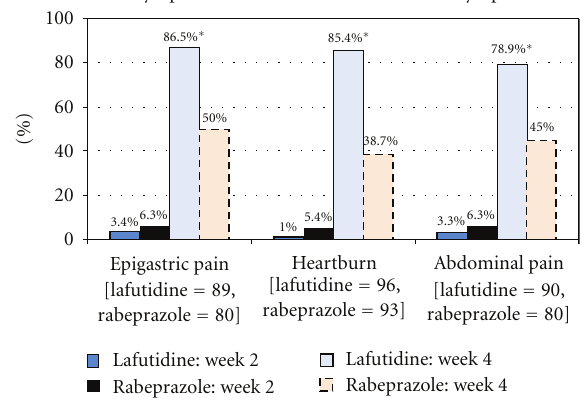
Figure 3: Proportion of patients who reported symptom resolution for each individual symptom from baseline. The number of patients listed for each symptom is the number of patients that reported that symptom with a GOS score ≥ 4 at baseline. ∗ P < . 01 between the two treatment groups at week